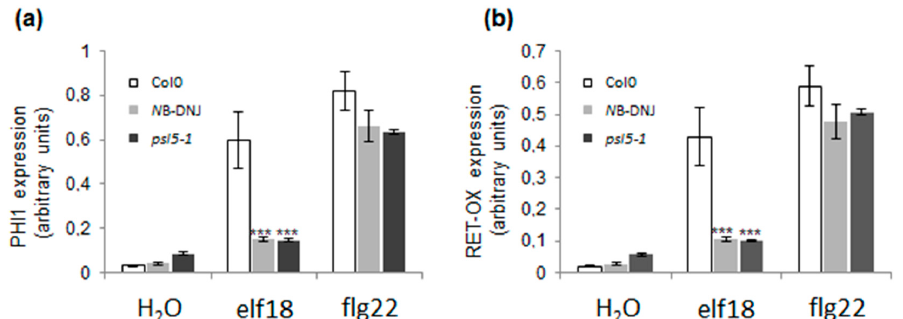
Figure 3. Transcription of defense genes. Arabidopsis thaliana WT (wild-type, empty bars), WT grown in the presence of N B-DNJ (70 µM, light grey bars) and psl5-1 (dark grey bars) 10-day-old seedlings (20 seedlings in each experiment) were treated with water or elf18 and flg22 elicitors. Transcription of PHI1 and RET-OX genes were determined by qRT-PCR 30 min after treatment. Transcription levels are shown as the mean of at least three independent experiments (± s.e.; n = 3) normalized to UBQ5 (ubiquitin 5) used as a reference. In both ( a ) and ( b ), asterisks indicate statistically significant differences between elf18-treated seedlings (WT + N B-DNJ and psl5-1 ) and corresponding treatment of the wild type according to Student’s t -test (3 asterisks = p < 0.001).